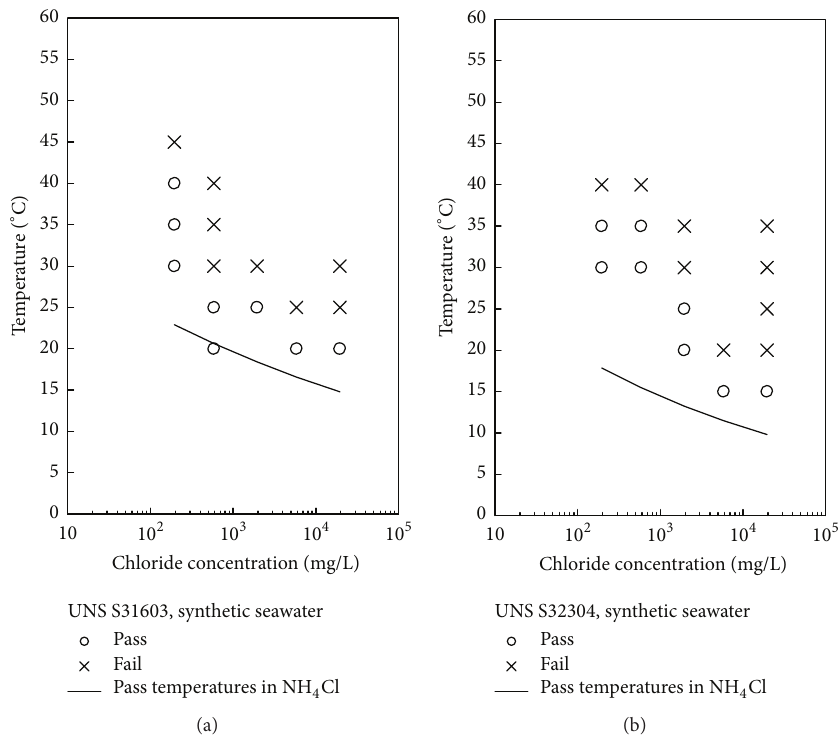
Figure 10: Pass-fail chart of UNS S31603 and S32304 in Type I synthetic seawater.